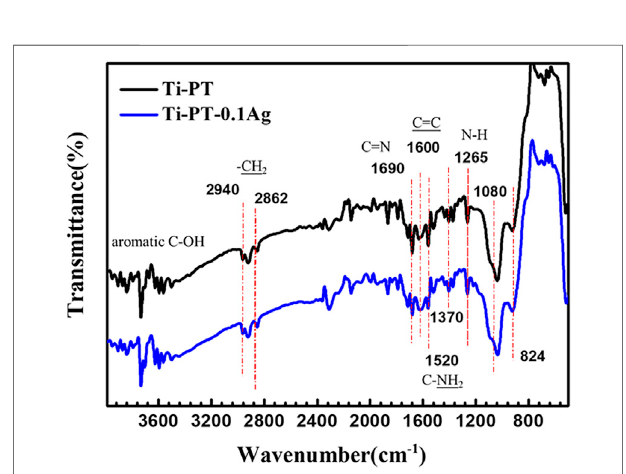
FIGURE 3 | FTIR spectra of Ti-PT and Ti-PT-0.1Ag.